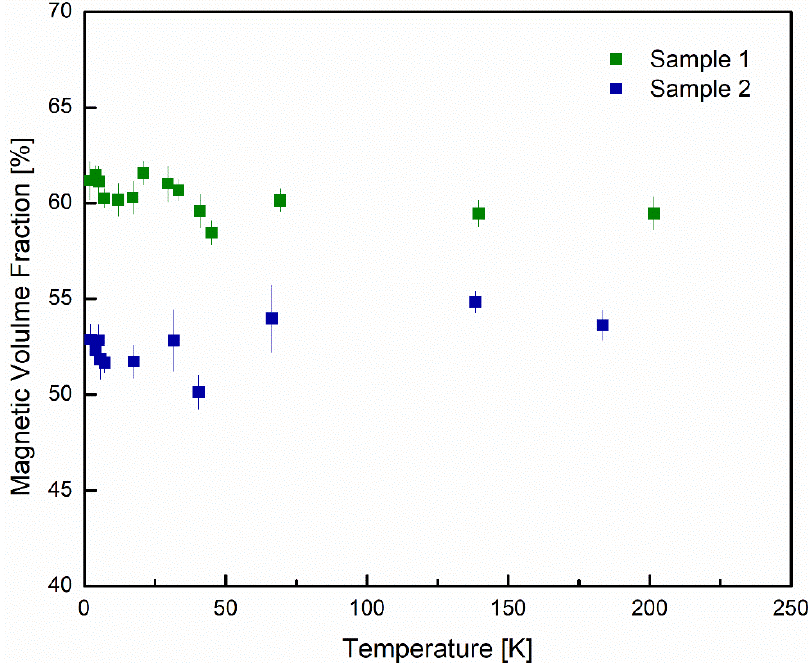
Figure 9. Percent magnetic volume fraction for samples 1 (green) and 2 (blue) with increasing tem- perature. The average percent magnetic fractions for samples 1 and 2 are 65% and 74%, respectively.